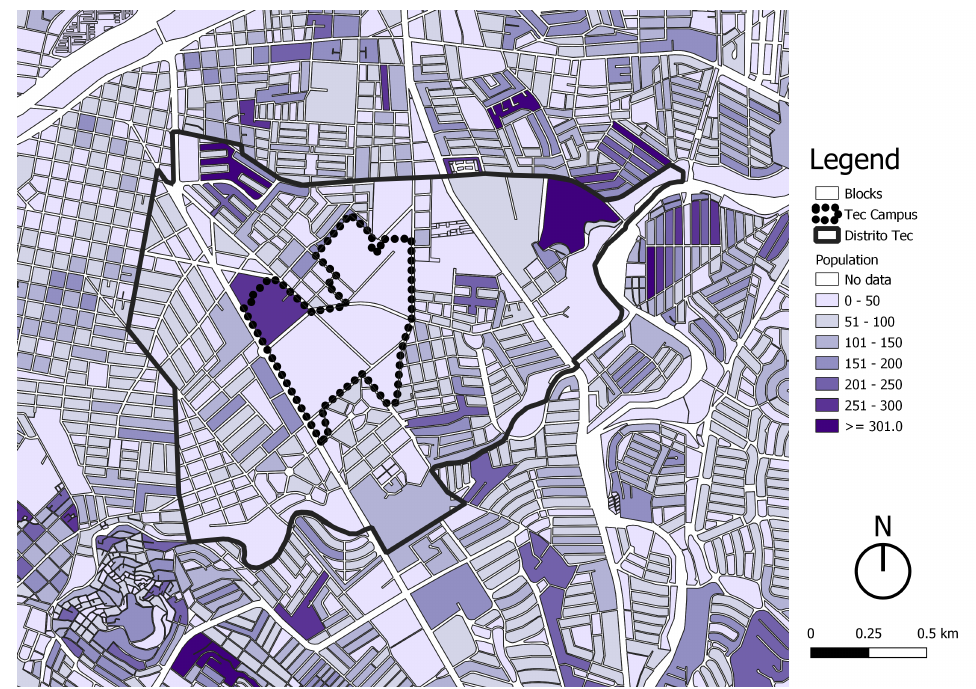
Figure 2. Population by block in Distrio Tec,